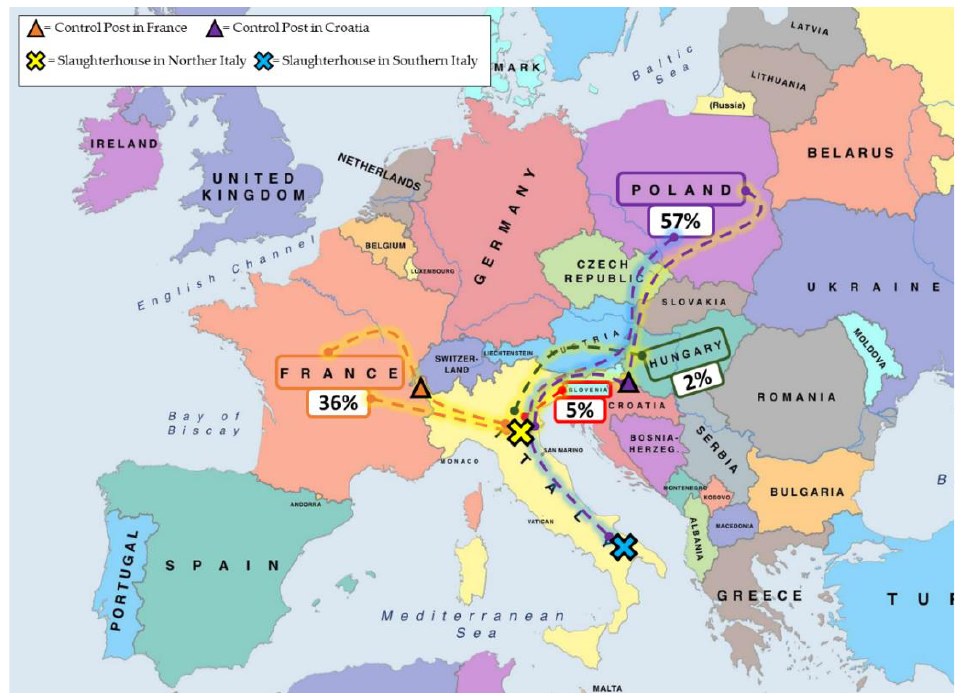
Figure 1. Departure countries of the 624 horses travelling to two Italian slaughterhouses between June 2021 and April 2022. In the boxes is the percentage of horses departing from each country. Poland (350/624 horses; 56%), France (220/624 horses; 35%), Slovenia (29/624 horses; 5%), Hungary (11/624 horses; 2%), Croatia (3/624 horses; 0.5%), Czech Republic (3/624 horses; 0.3%), Ireland (2/624 horses; 0.3%), United Kingdom (2/624 horses; 0.2%), Germany (1/624 horses; 0.2%), and Holland (1/624 horses; 0.2%) were the horses’ countries of origin. All journey details are reported in Table